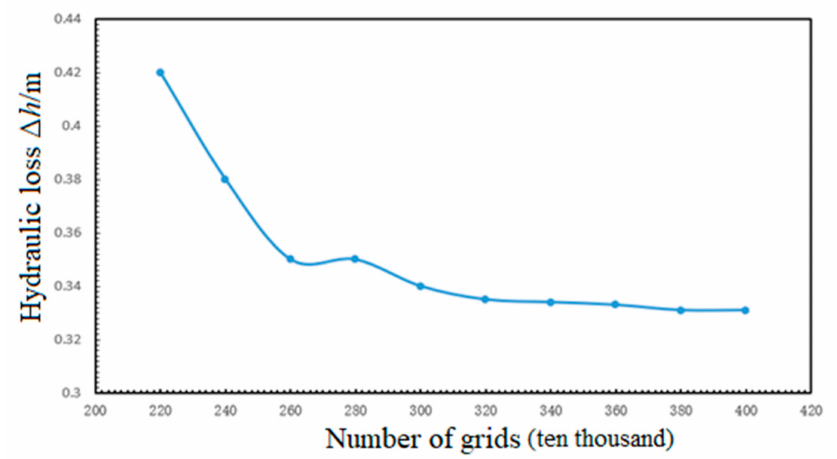
Figure 4. Grid independence verification.